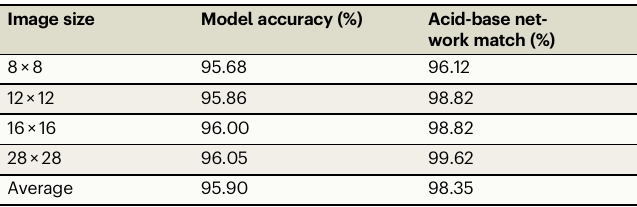
Table 4 | Matching accuracy for 3-class, binary image classi fi er Image size Model accuracy